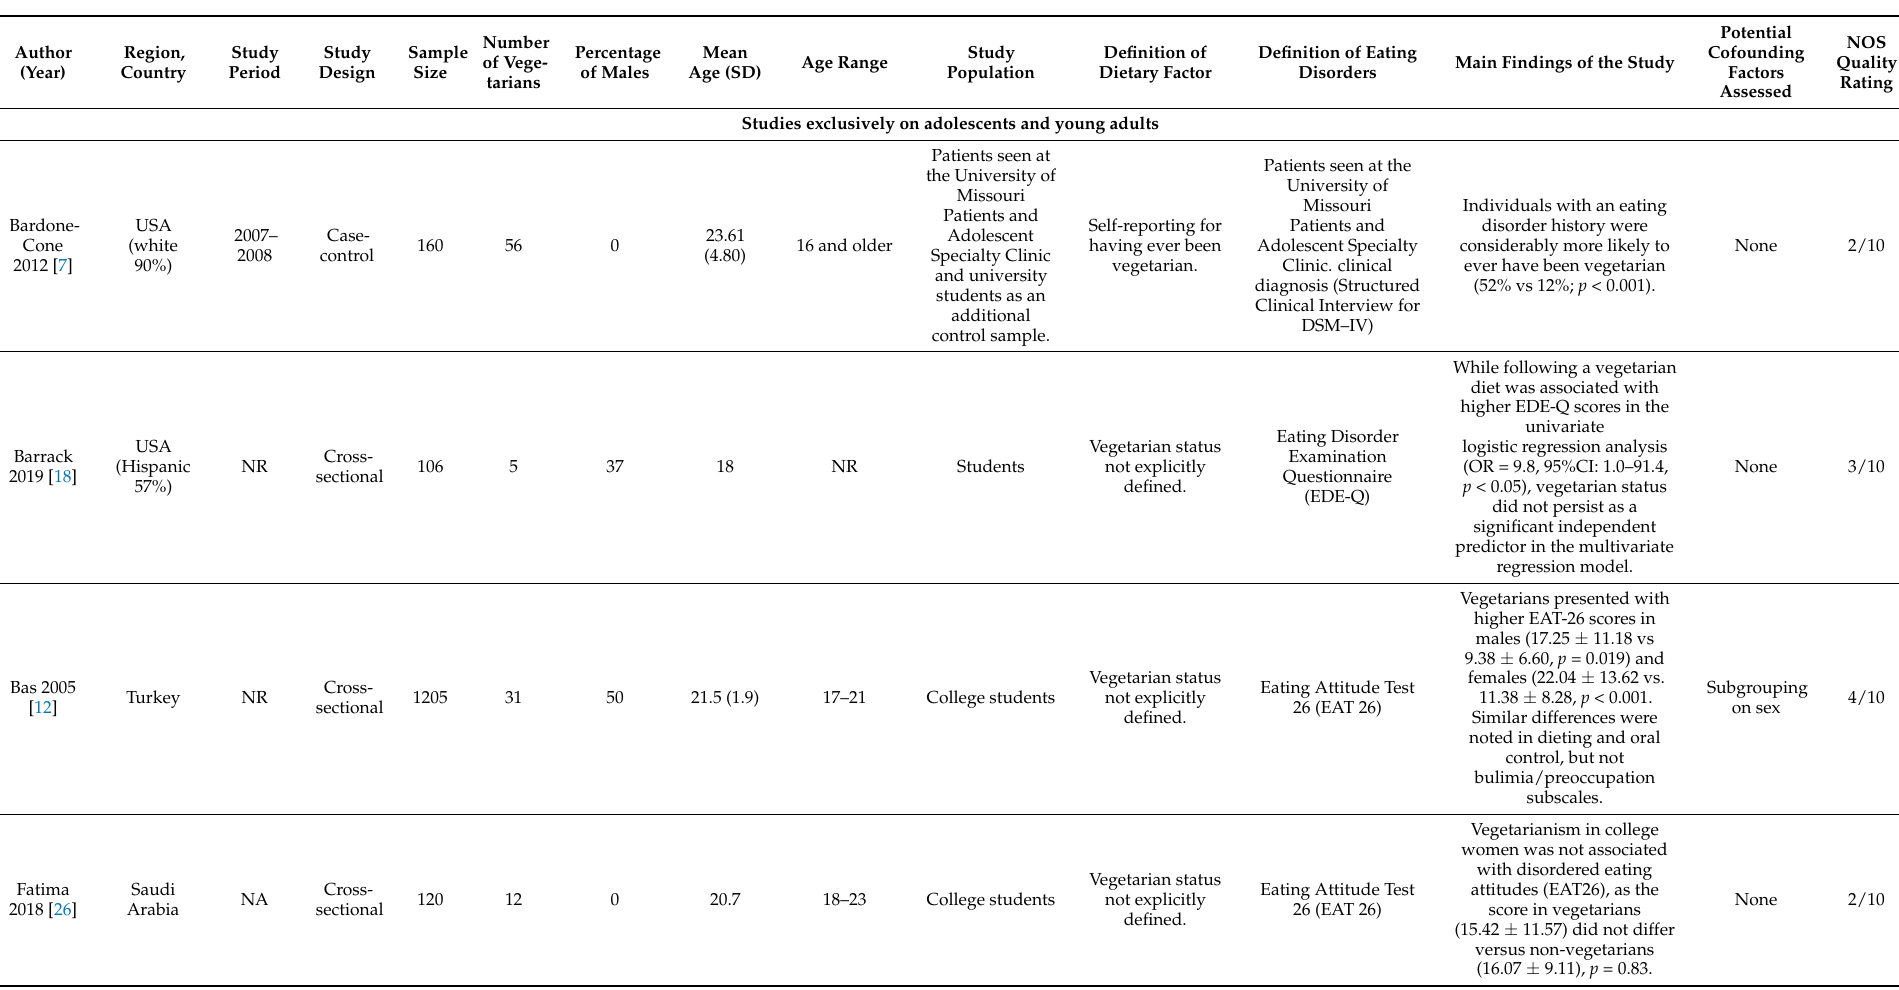
Table 1. Characteristics of included studies. Upper panels present studies encompassing exclusively on adolescents and young adults; middle panels present studies on youth, but with admixture with older individuals; lower panels present studies on prognosis/features of eating